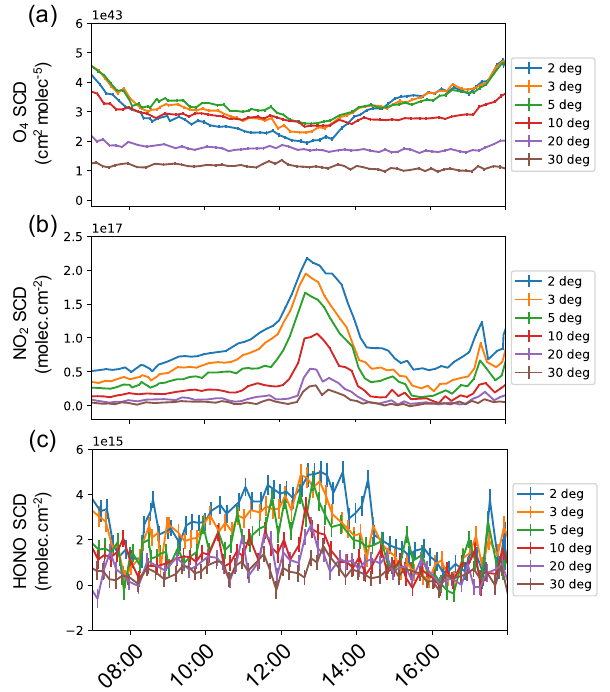
Figure 3. Diurnal differential slant column profiles for (a) O 4 , (b) NO 2 and (c) HONO for 4 March